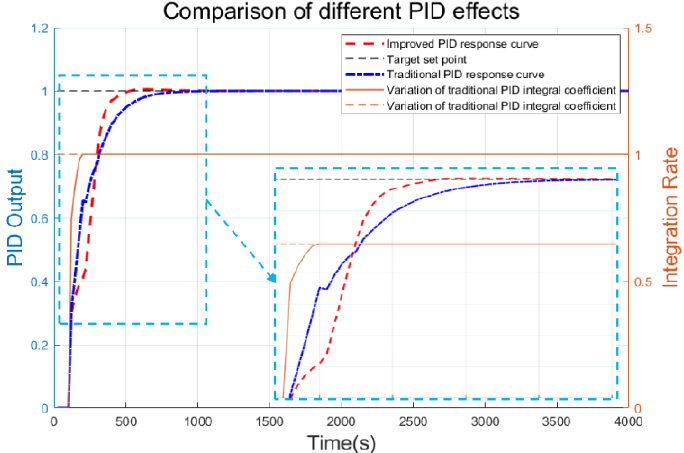
Figure 14. Comparison between PID after integral improvement and traditional PID.